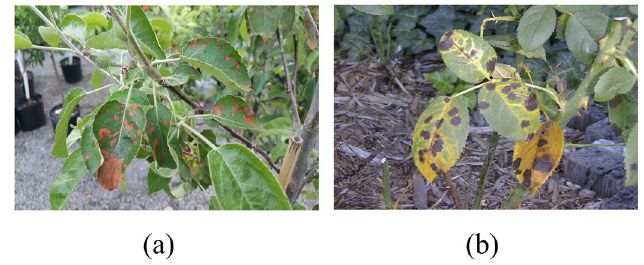
Figure 2. PlantDoc disease images. ( a ) Rust; ( b ) Scab.